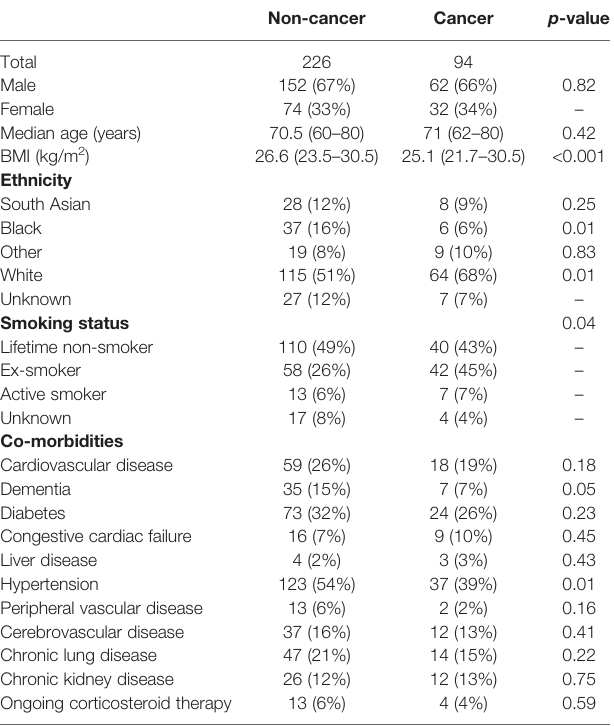
TABLE 1 | Demographic data of patients with SARS-CoV-2 infection. Data is shown as n (%) or median (IQR). Non-cancer